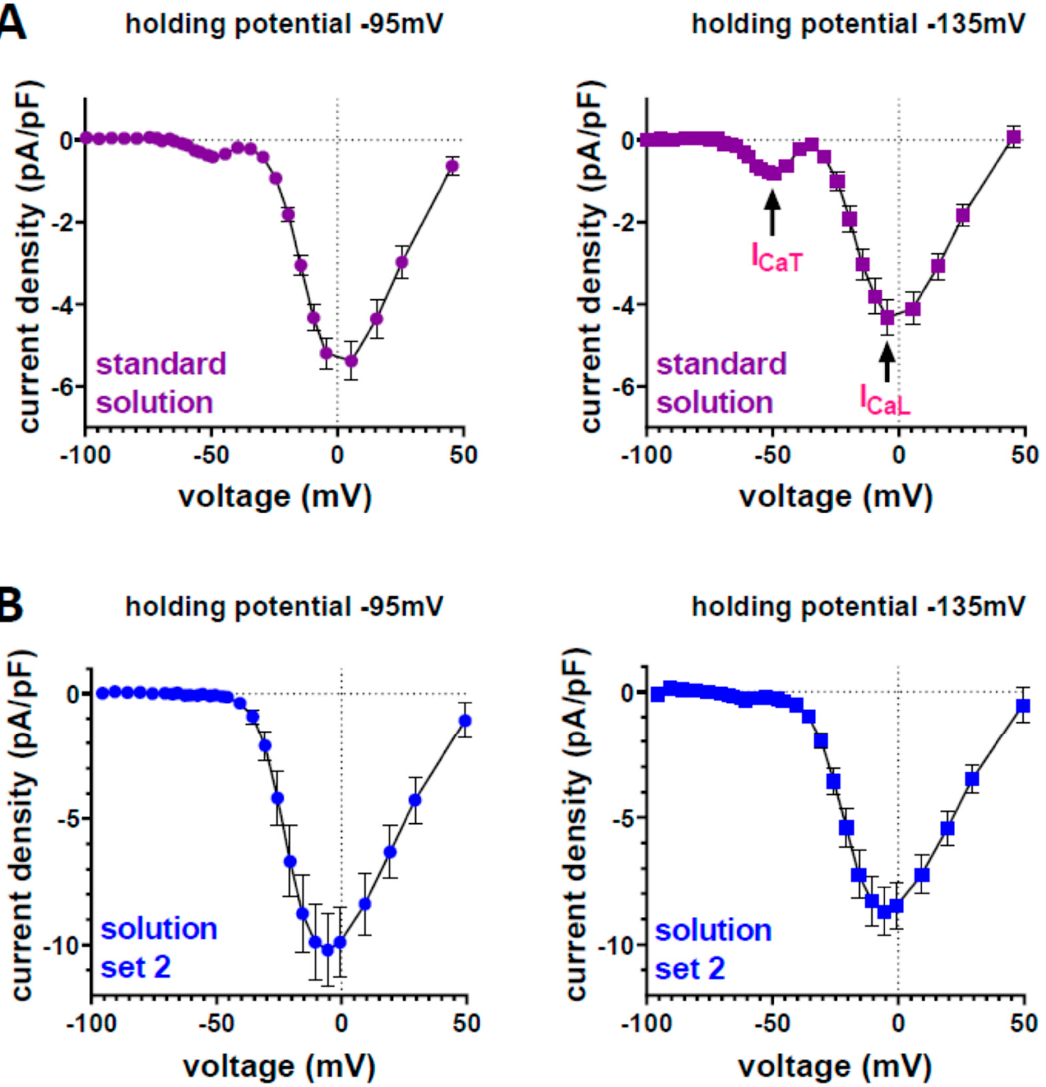
Figure 3. Ca current density–voltage relationships recorded from ventricular cardiomyocytes isolated from wt BL/10 mouse hearts under different experimental conditions. ( A ) Left: standard solution (see Materials and Methods) at holding potential − 95 mV; T/L-type current amplitude: 9%; Right: standard solution at holding potential − 135 mV; T/L amplitude: 19%; a significant difference existed between different ICaT amplitudes at − 50 mV ( p = 0.006, paired Student’s t -test). Data represent means ± SEM (n = 11). ( B ) Left: solution set 2 (see Materials and Methods) at holding potential: − 95 mV; T/L amplitude: 0%; Right: solution set 2 at holding potential: − 135 mV; T/L amplitude: 5% (n = 14).